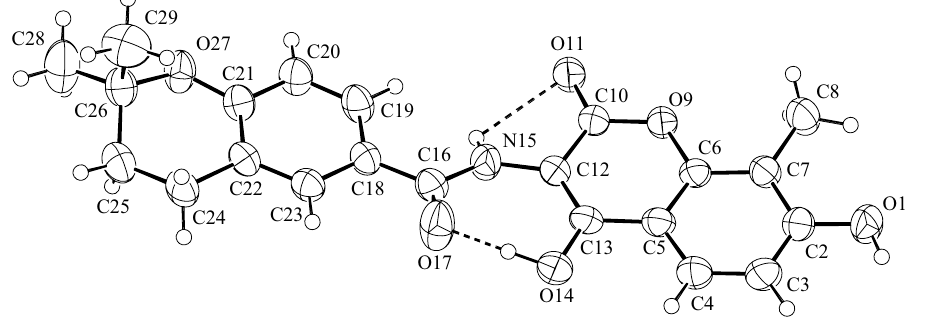
P4 plane [C18-C24/O27] from 0.380(3) Å and 0.335(3) Å, re-